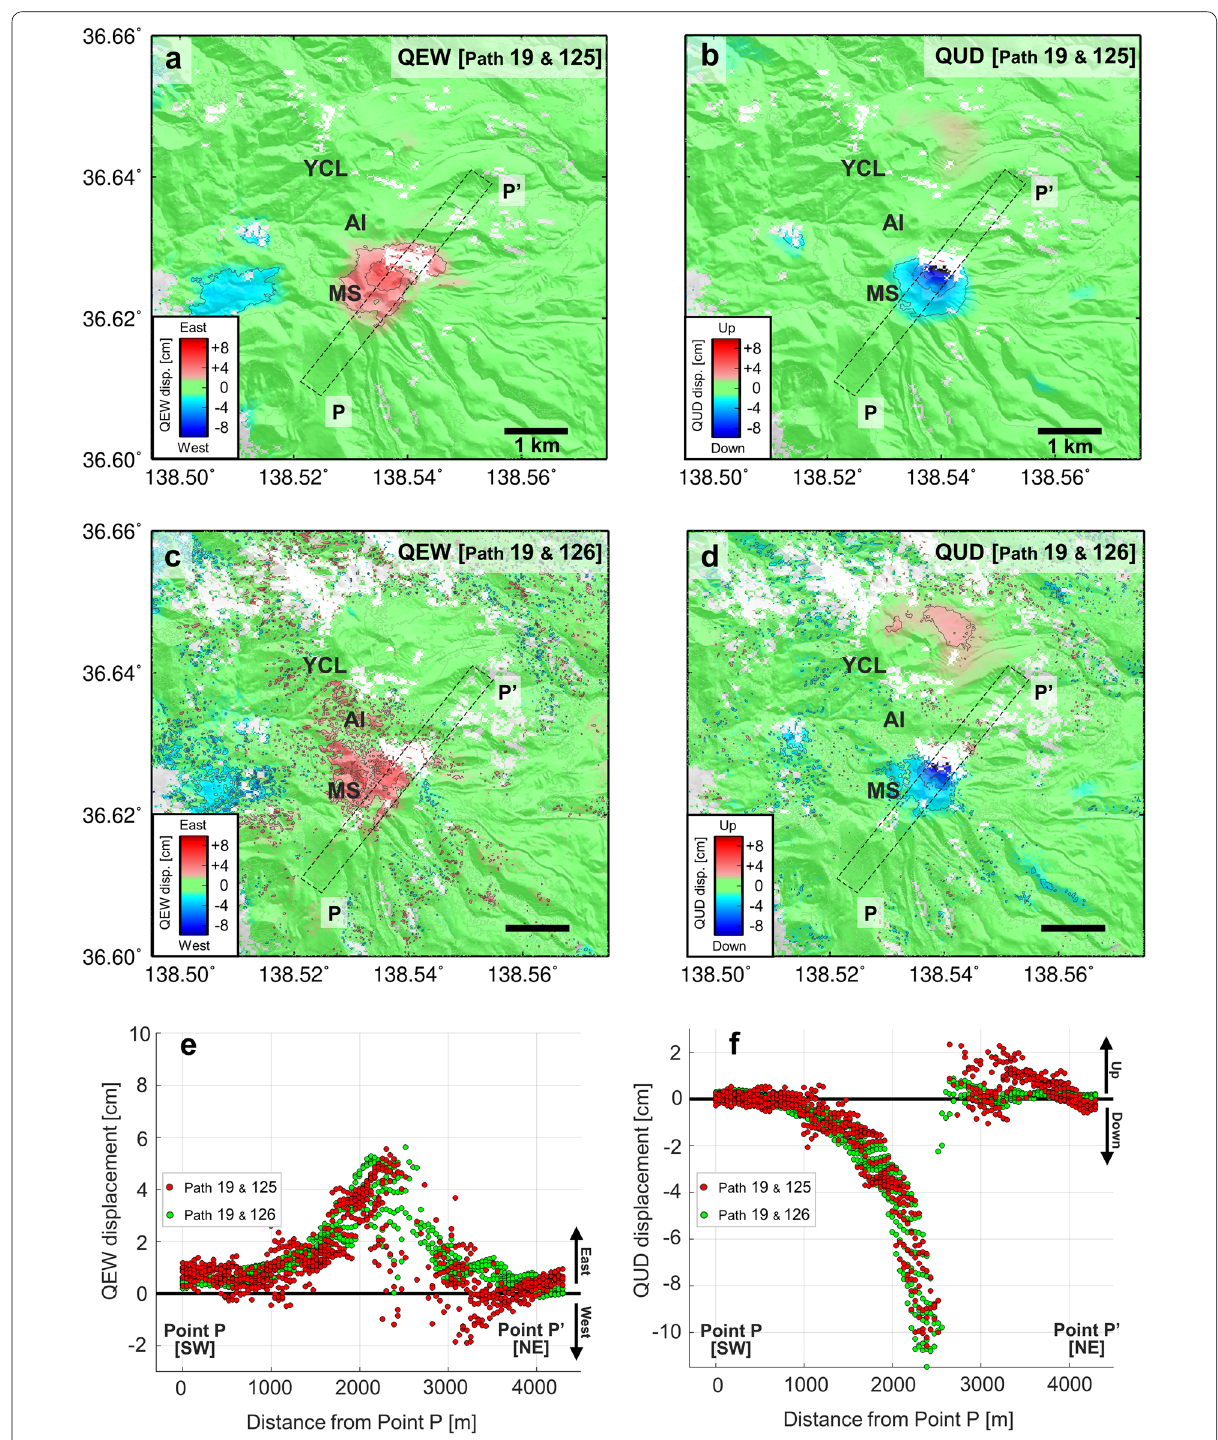
Fig. 3 Quasi-east–west (QEW) and quasi-up–down (QUD) components of the coeruptive deformation. a – d Decomposed QEW and QUD components using pairs of paths 19/125 and 19/126, respectively. Contours indicate 2 cm intervals of each displacement component. Positive values of QEW and QUD components indicate eastward displacement and uplift, respectively. e , f Cross sections of QEW and QUD components along the P–P’ profile. The profile locations are shown in ( a – d ). The plotted dots are the values of each displacement component in pairs of paths 19/125 and 19/126 within the boxes along the P–P’